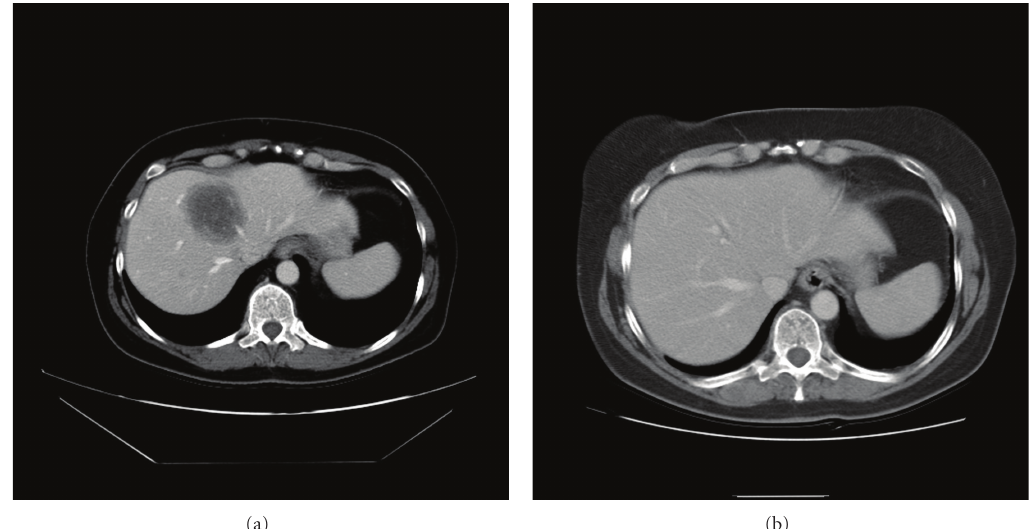
Figure 2: A computed topography of the abdomen shows a large hypodense hepatic metastasis before the TACE (a), which has disappeared following the TACE